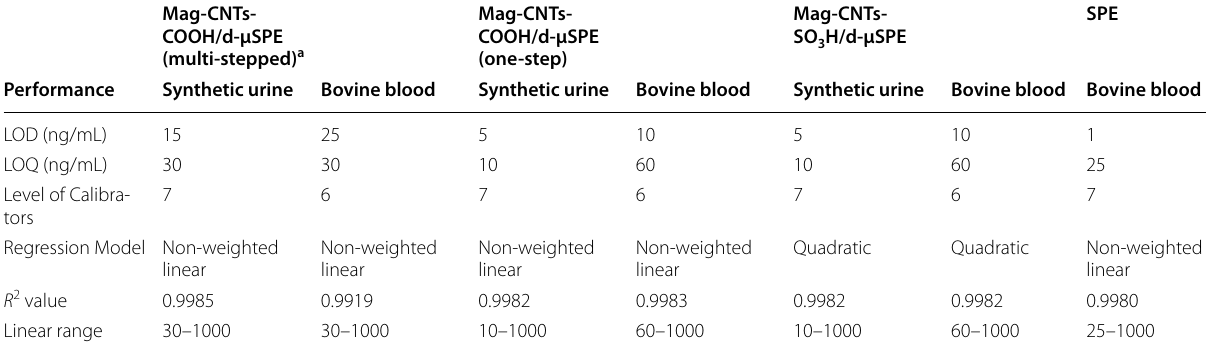
a Data was obtained from Li et al. (2019a)